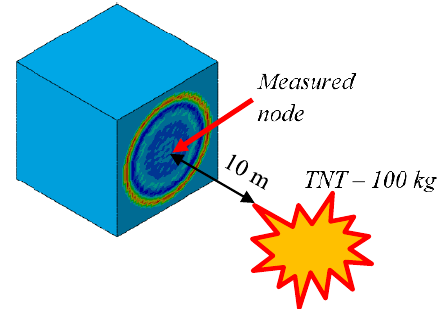
Figure 10. Task performed in order to select the appropriate size of acoustic element — detonation of 100 kg of TNT at a distance of 10 m.